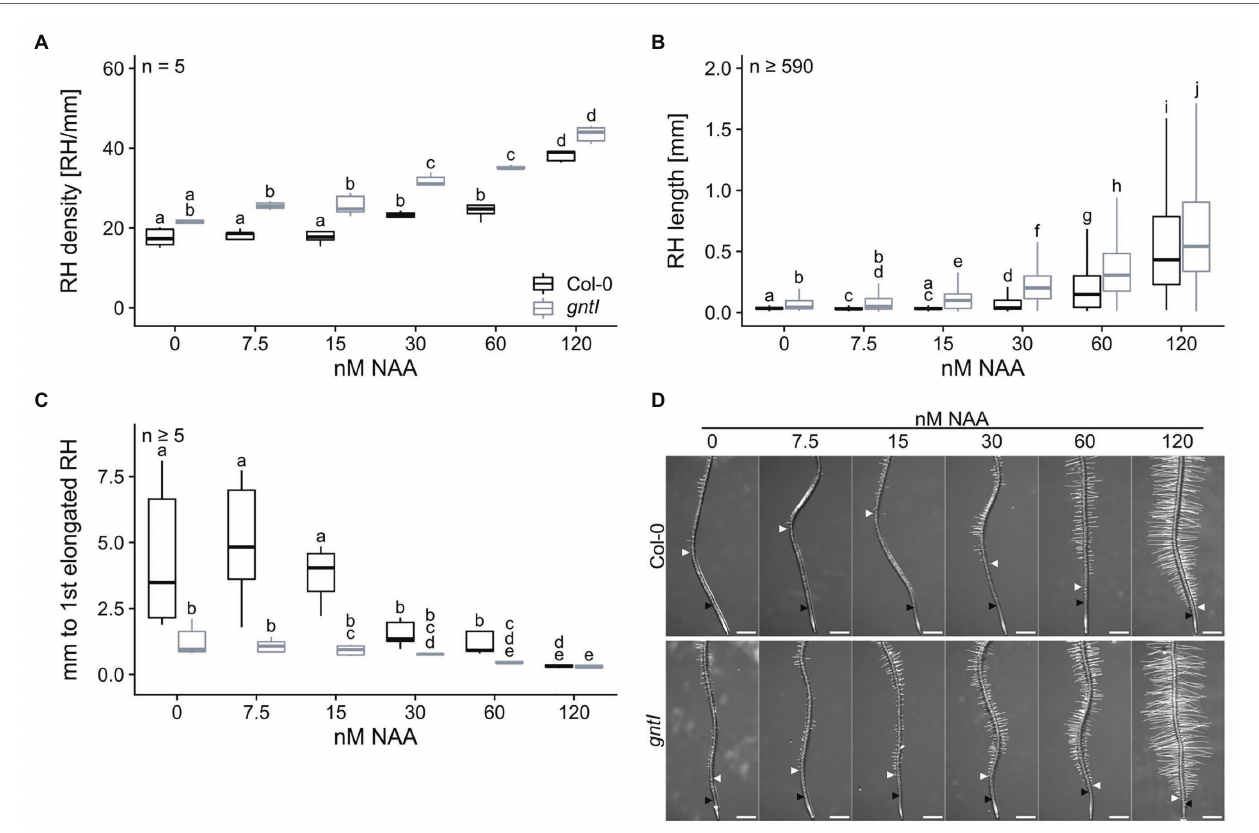
FIGURE 4 | Plants lacking complex N-glycans display an altered auxin response. (A) root hair density, (B) root hair length, and (C) distance between first general and first partially elongated root hair of wild-type (Col-0, black boxes) and gntI plants (gray boxes) cultivated for 8 days on plates supplemented with the indicated NAA concentrations. Letters indicate significant differences between groups [ p ≤ 0.05; (A,C) two-way ANOVA with Tukey post hoc test; (B) Kruskal-Wallis test, FDR corrected via Benjamini-Hochberg]. (D) Pictures of representative root tips. Black arrows indicate the first general root hair while white arrows point to the first partially elongated root hair. Scale bars: 500 μ